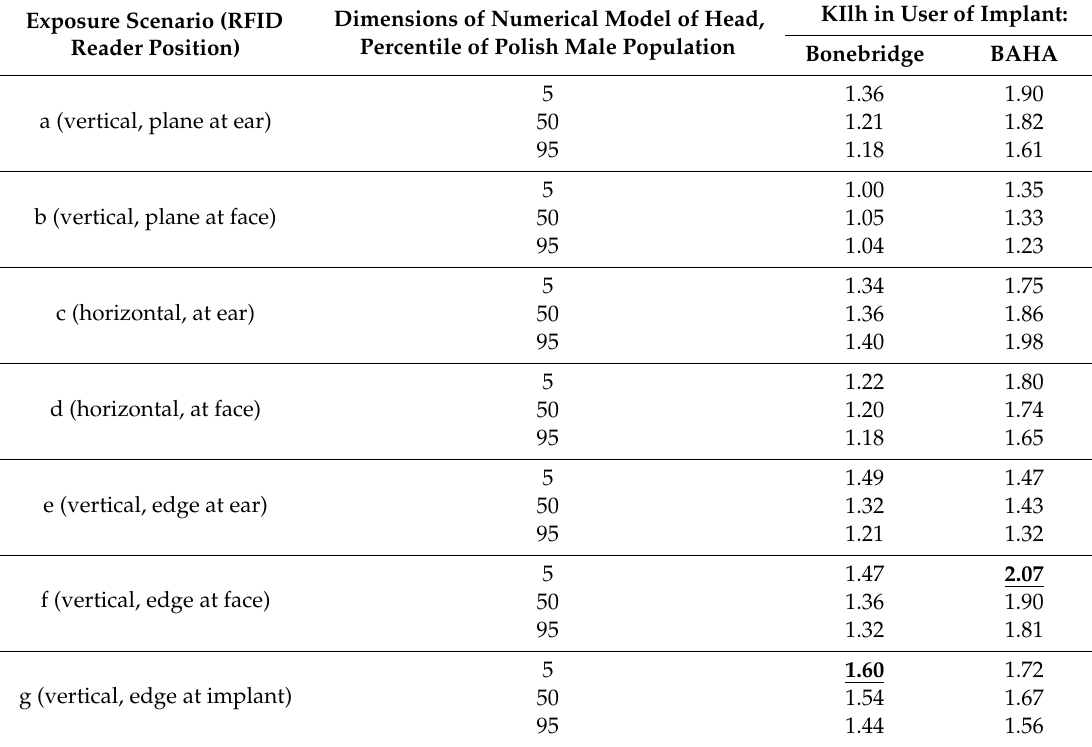
Table 2. Comparison of localized SAR averaged over any 10 g of tissues in the head (SARlh) under exposure to an EMF at a frequency of 13.56 MHz (emitted by an RFID HF reader) in the head of a hearing implant user and a